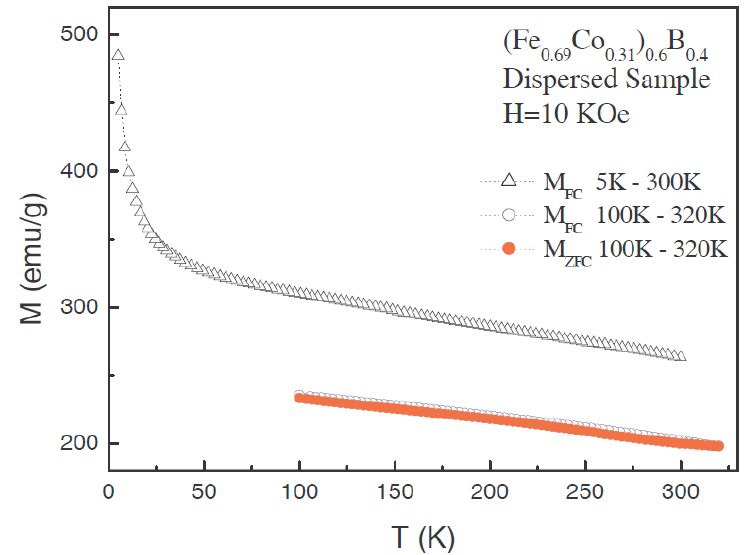
Figure 6. Magnetization vs. temperature measured, applying a field of H = 10 kOe: cooling the sample down to T = 5 K with the field (open triangles), cooling the sample in zero field down to T = 100 K (open circles), and cooling applying the field down to T = 100 K (solid